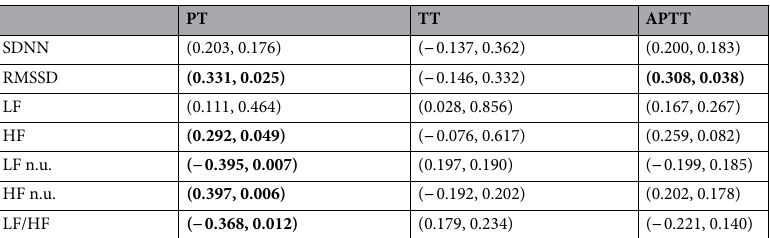
Table 2. Bivariate correlation between HRV parameters and RCIs. PT prothrombin time, TT thrombin time, APTT activated partial thromboplastin time, SDNN standard deviation of normal-to-normal intervals, RMSSD the root mean square of successive heartbeat interval differences, LF low-frequency power, HF high-frequency power; LF n.u. low-frequency power in normalized units, HF n.u. high-frequency power in normalized units, LF/HF the ratio of low-frequency power to high-frequency power. Values are expressed as ( r , P ). Bold text indicates statistical significance at P < 0.05.